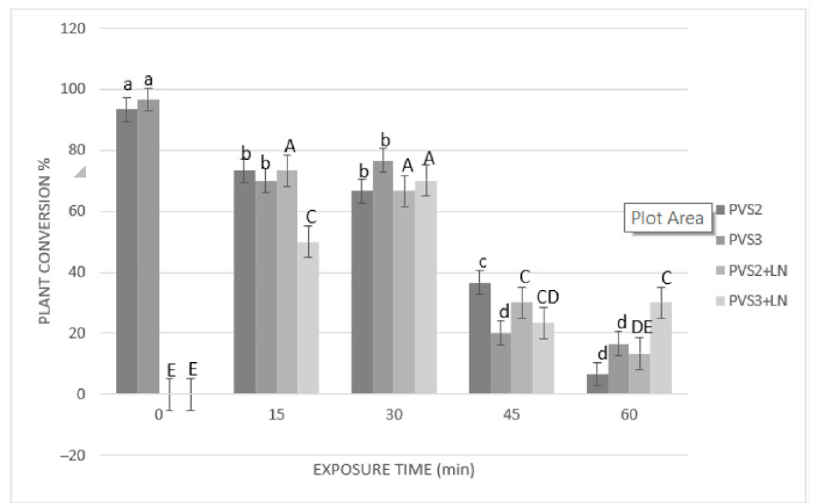
Figure 4. Effect of exposure length to PVS2 or PVS3 at 0 ◦ C on the conversion of somatic embryos (SEs) to plants before and after cryopreservation. SEs were precultured on MS solid medium with 0.3 M sucrose in the dark for one day, encapsulated over the cryoplate with calcium alginate (2%) containing 0.4 M sucrose, and loaded with 1 M sucrose + 2 M glycerol for 15 min before exposure to PVS solution. Data are represented by means (%) ± standard error (se). Bars with the same letter are not significantly different p ≤ 0.05 (LSD test). Lowercase letters refer to non-cryopreserved controls, and uppercase letters refer to cryopreserved (+LN) samples. Conversion to plants of cryopreserved SEs was evaluated after 105 days of culturing on MS